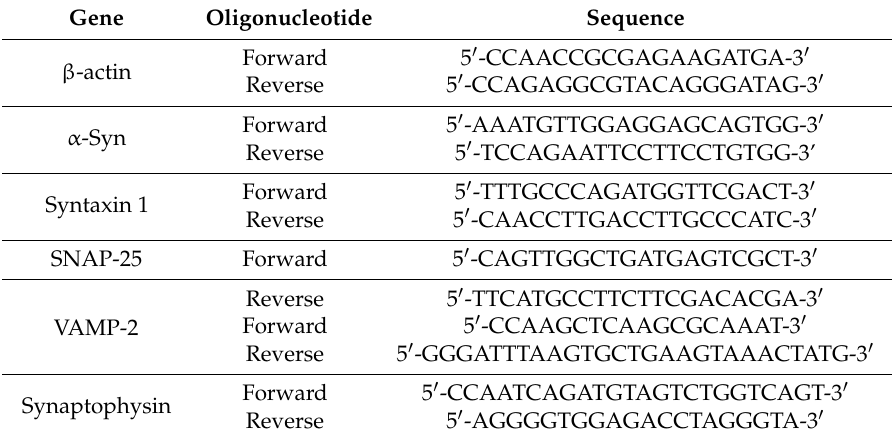
Table 1. Primers used to establish the cDNA amplification standard curves by conventional